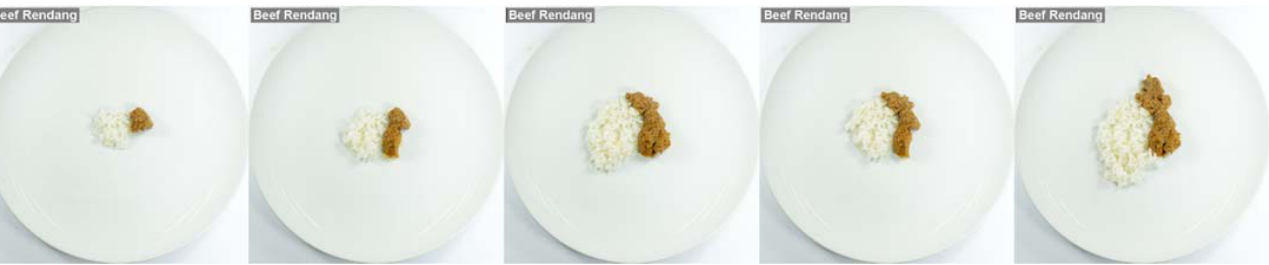
Figure 1. Sample images from the computerized portion selection task.